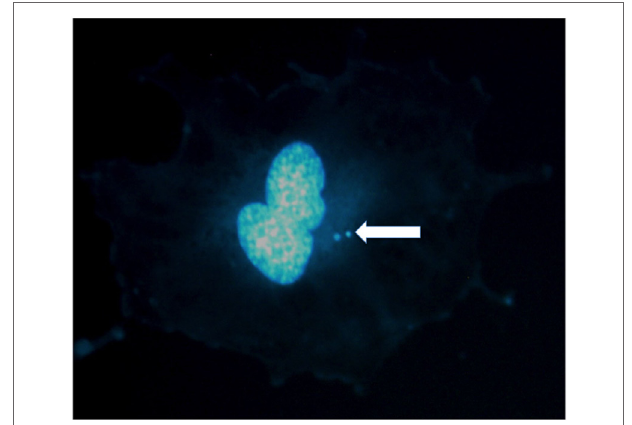
FiGURe 1 | Micronuclei in the cytoplasm of a human umbilical vein endothelial cell exposed to X-rays. Two micronuclei are visible in this binucleated cell stained in DAPI. Photo courtesy of Dr. Alexander